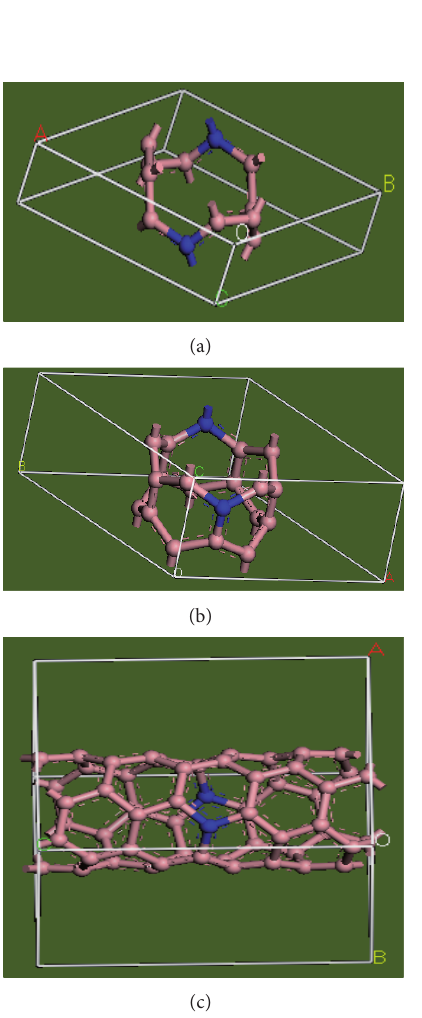
Figure 2: The ball and stick model of two atoms of nitrogen doped for (a) armchair (3,3), (b) zigzag (5,0), and (c) chiral boron nanotubes. The encircled blue atoms are of nitrogen while the brown are of